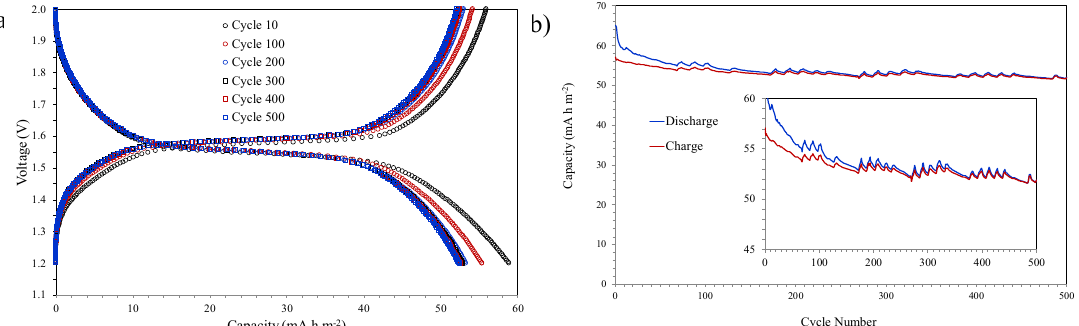
Figure 8. Galvanostatic discharge-charge test at 7 µ A cm − 2 of a sample treated at 600 ◦ C: ( a ) capacities vs. voltage curves at different cycle number, and ( b ) cycle number vs. capacities curves. The capacities vs. voltage curves at di ff erent cycle number (Figure 8a) do not present a